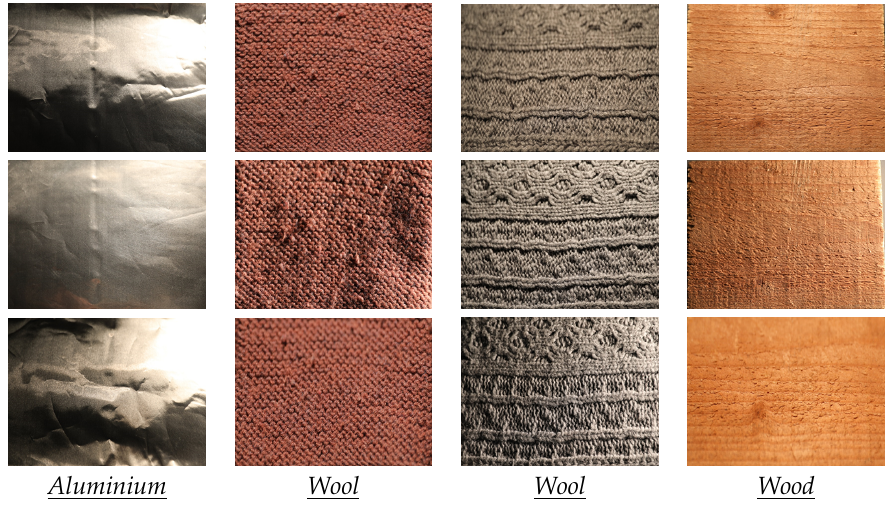
Figure 1. Appearance variation across acquisition conditions. The images of each column contain the same sample under different (lighting or viewpoint) conditions. These images are extracted from our new